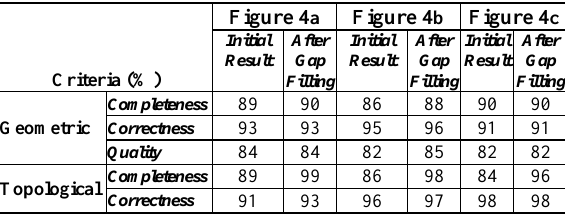
Figure 4 a Figure 4 b Figure 4 c